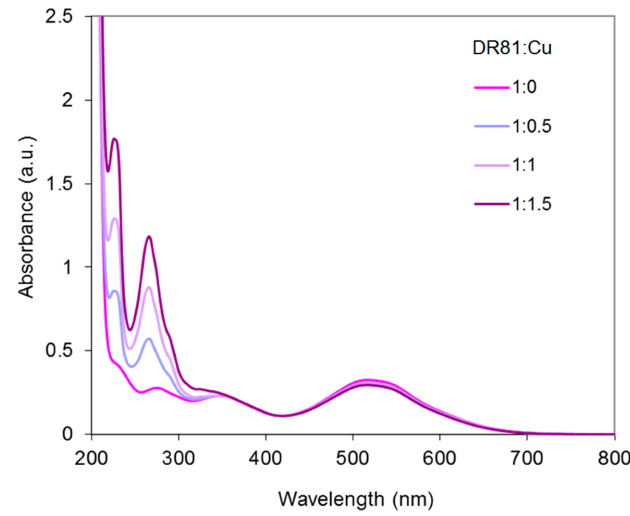
Figure 15. Absorbance spectra of the dye/copper-phenanthroline system at pH 12.3, with Cu:Phen molar ratio = 1:2 and [DR81] = 10 µ M, for different DR81:Cu molar